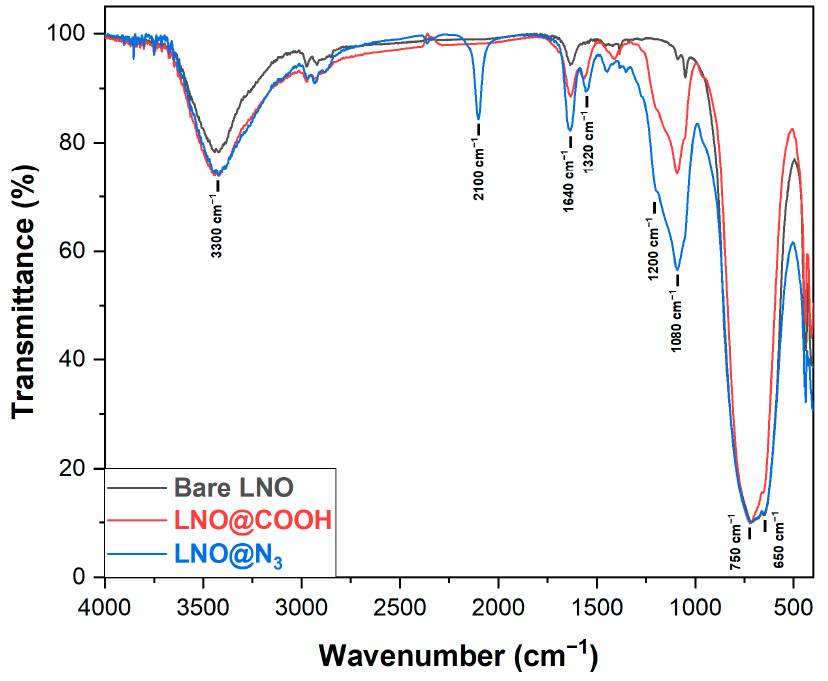
Figure 1. FTIR spectra of bare LNO (black), LNO@COOH (red) and LNO@N 3 (blue) NPs normalized with respect to the O-Nb-O bands.